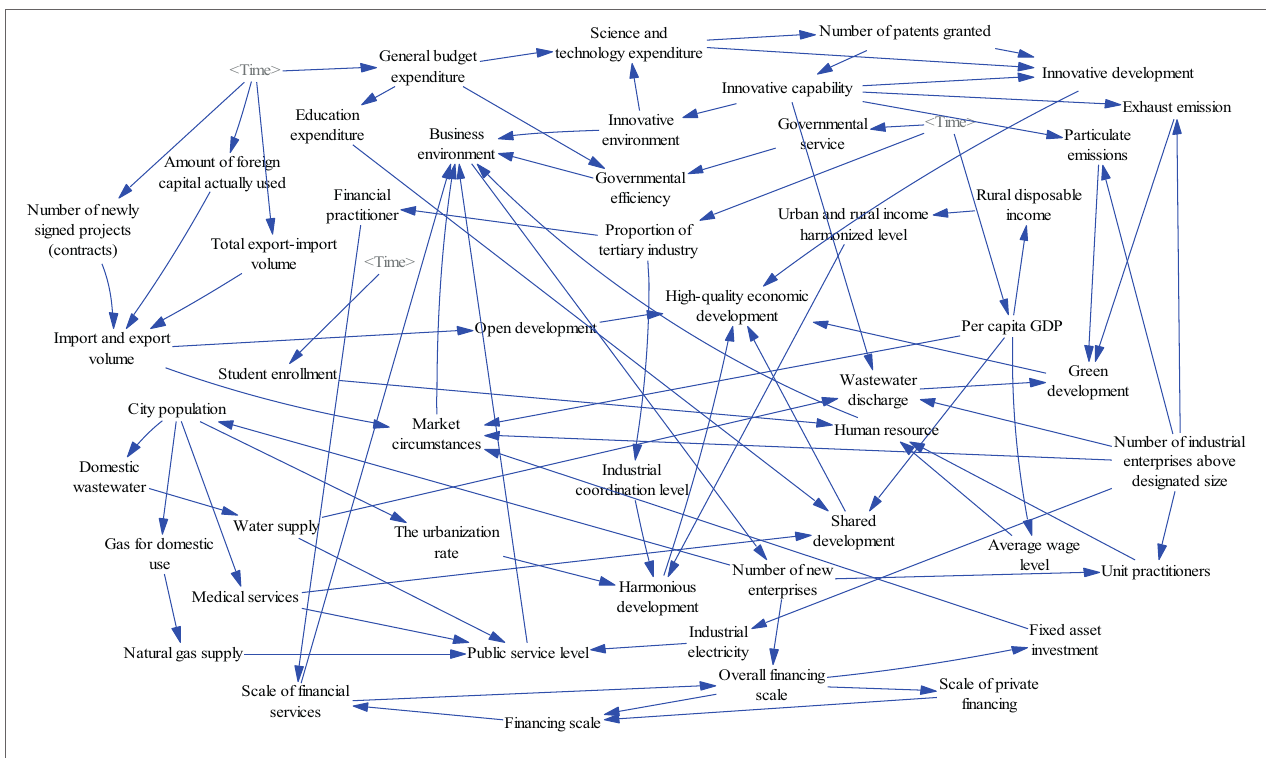
FIGURE 5 | Total system causality